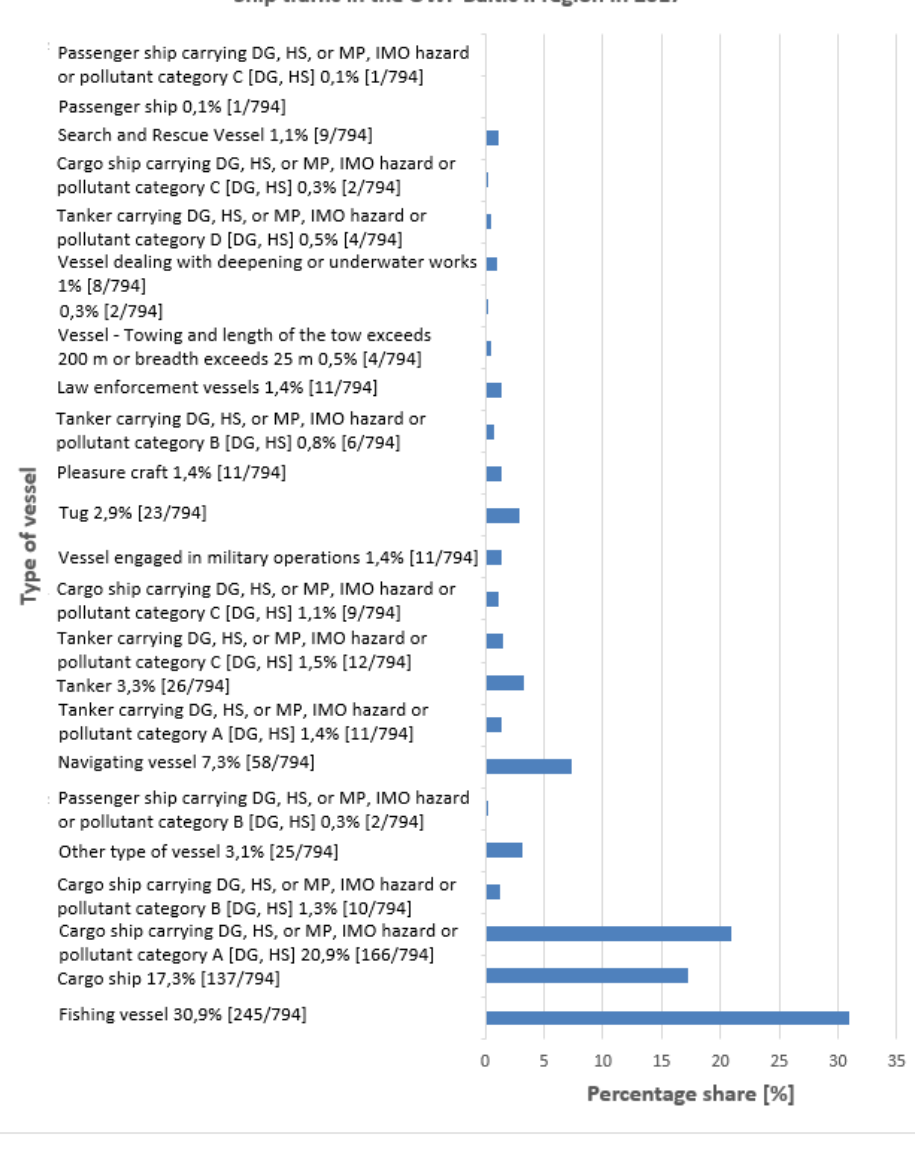
Figure 12. Percentage breakdown of ships by type in 2017. Table 9. List of ships on the measurement profile, broken down by type. Type of Vessel (Identifier